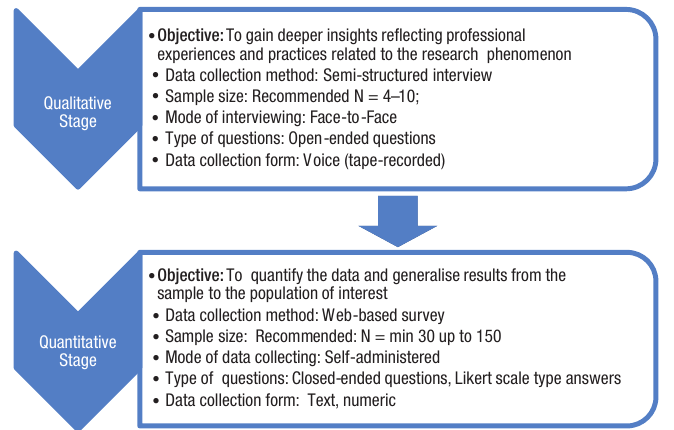
Fig. 5. Research data collection